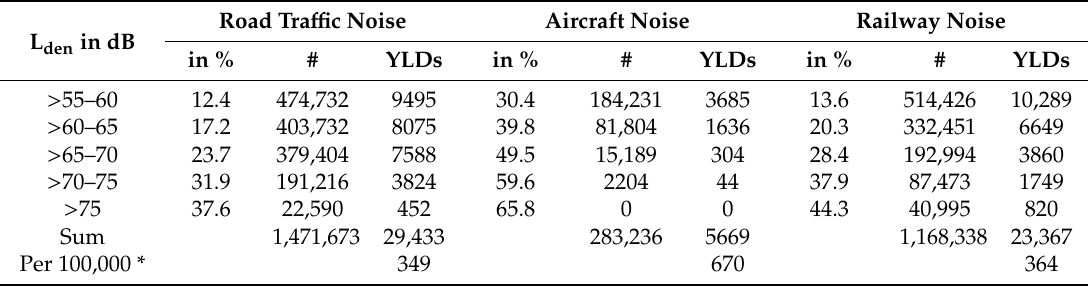
Table 7. Burden of disease due to annoyance attributable to tra ffi c noise in Germany, 2016.